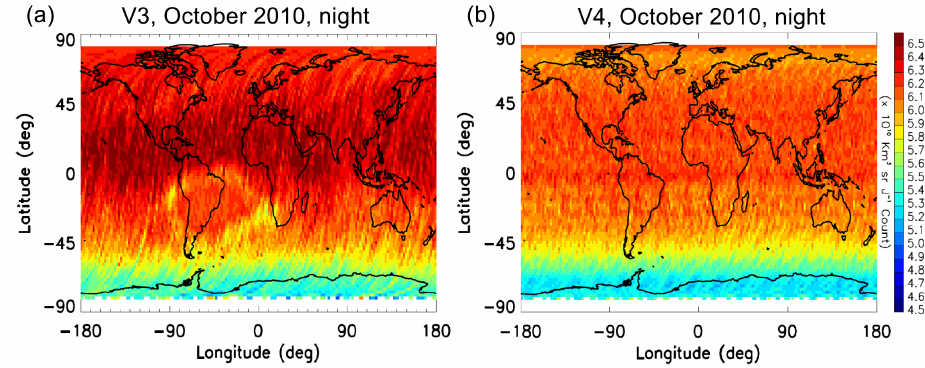
Figure 9. Spatial distribution of the 532nm nighttime calibration coefficient for October 2010, (a) from V3 and (b) from V4.